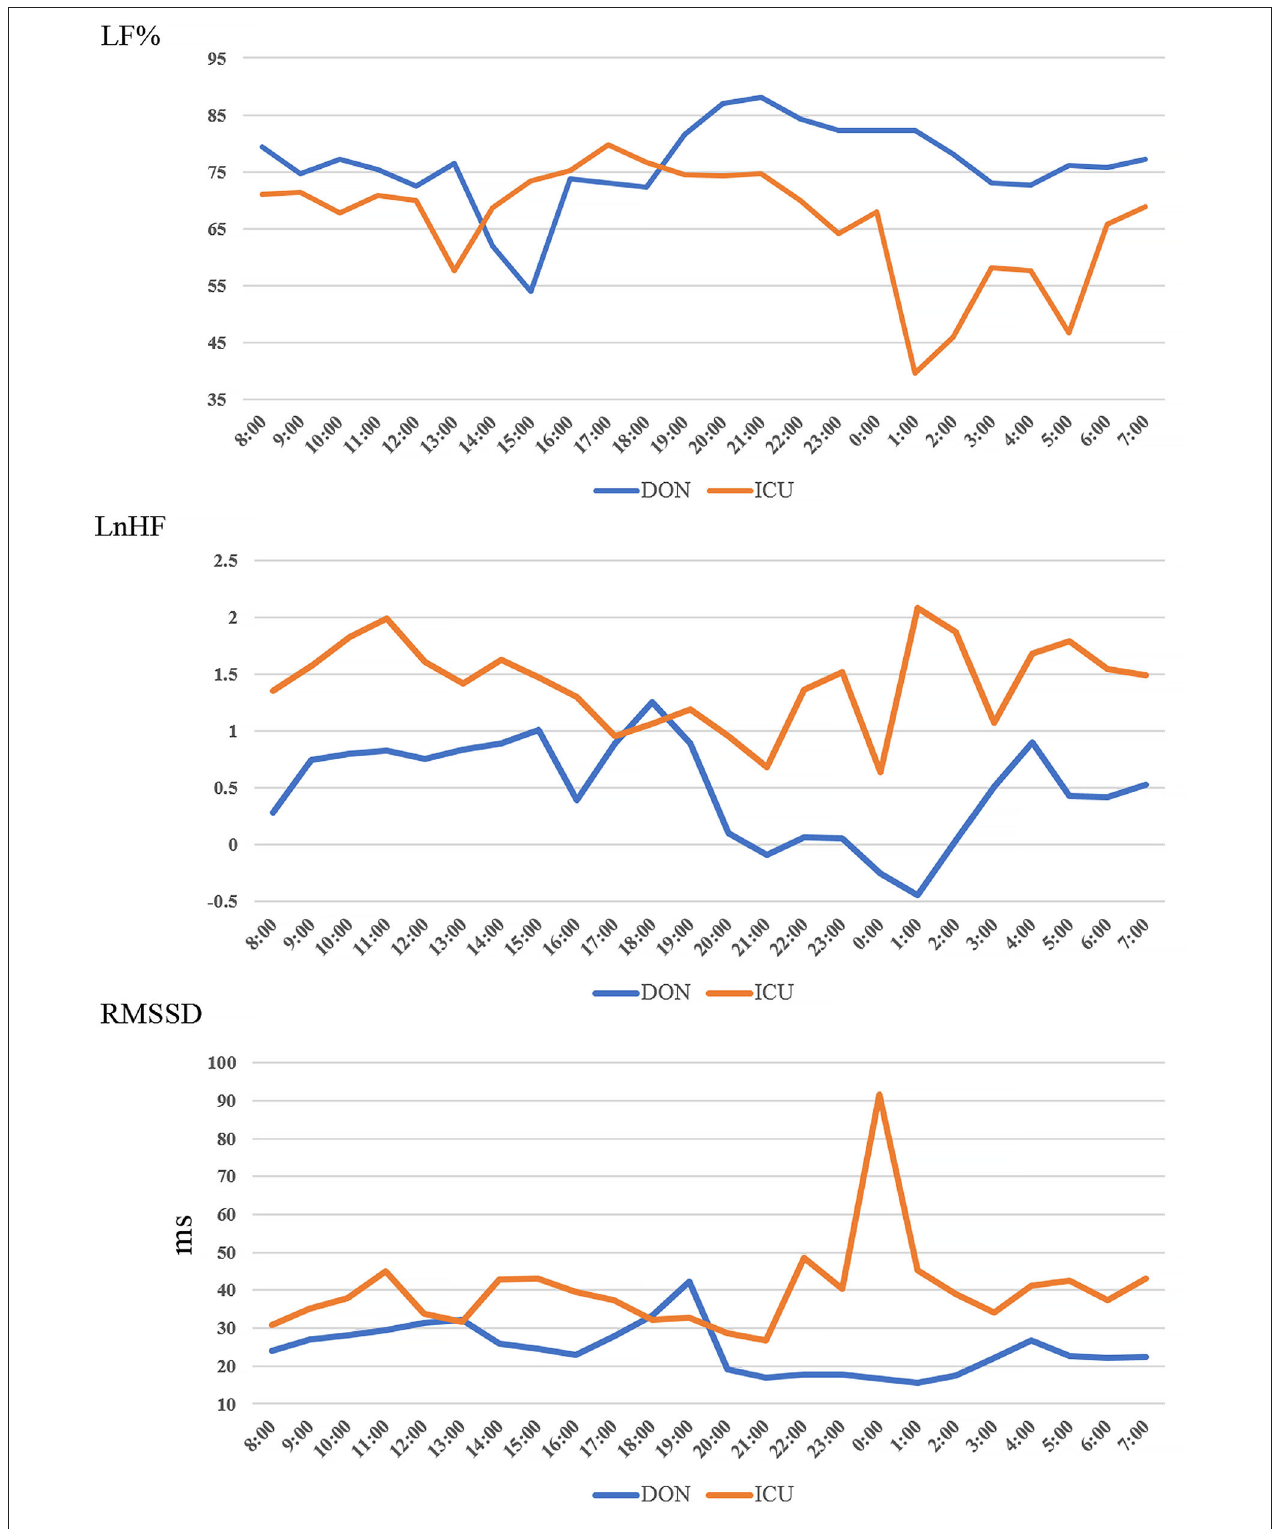
FIGURE 1 | Changes of HRV parameters for DON and ICU nurses in 24h.